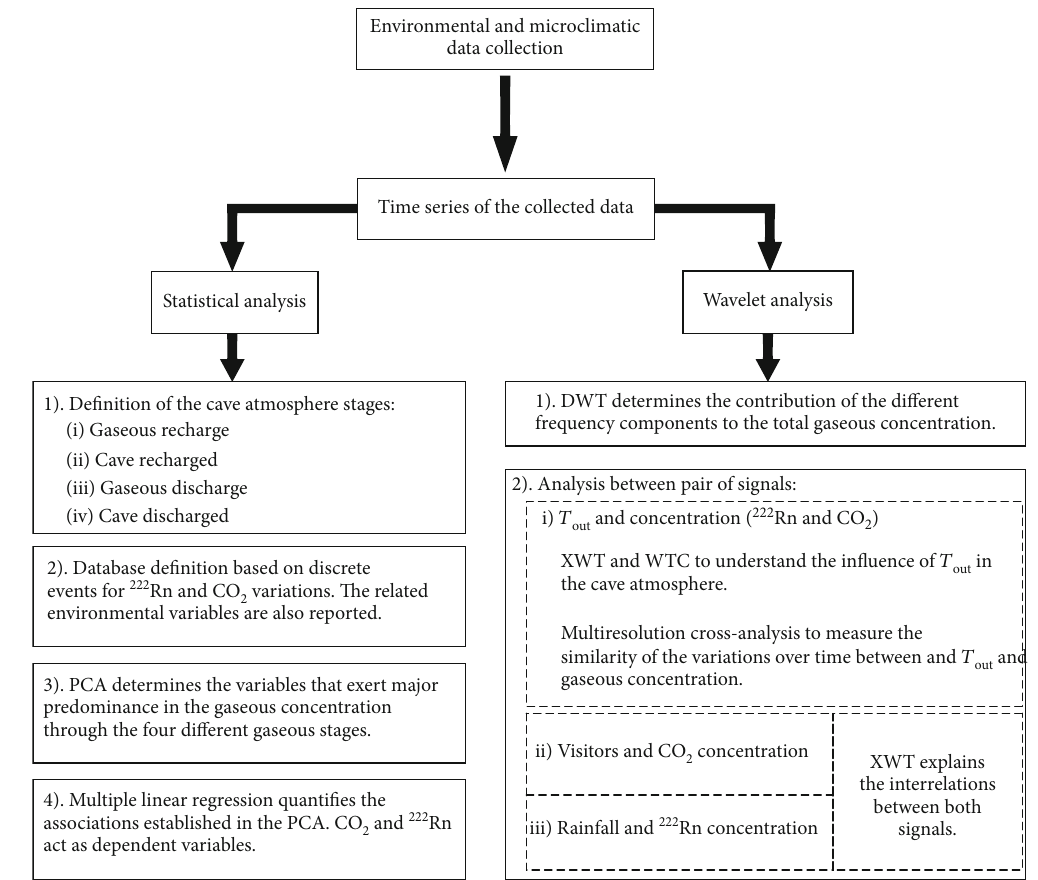
Figure 2: Work fl ow of the methodology applied to the data.